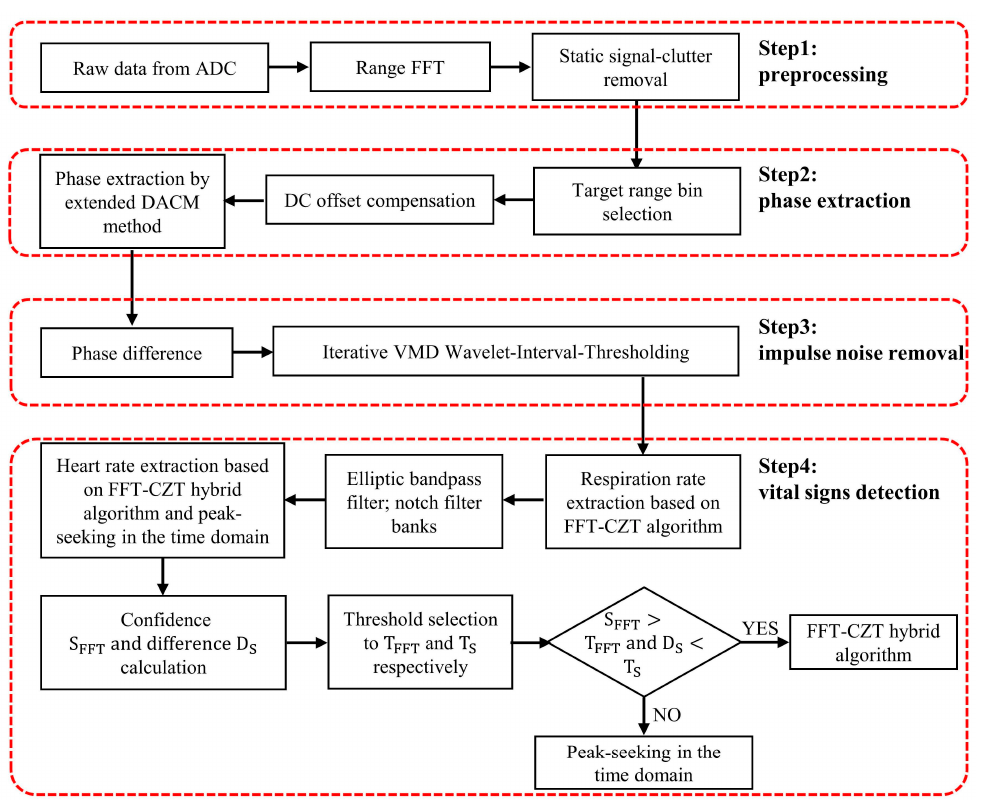
Figure 1. The proposed signal processing algorithm